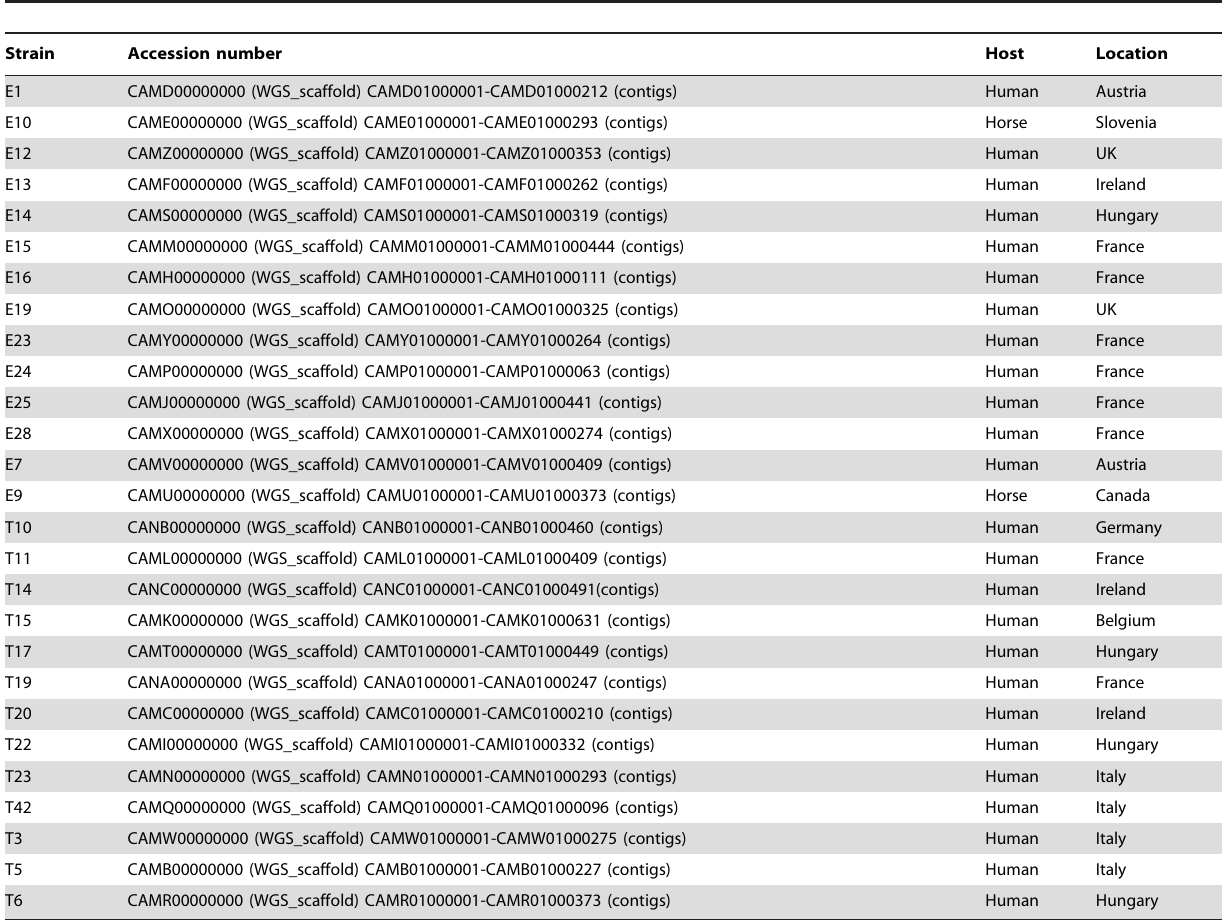
Table 1. Listing of accesion number, host and location of isolation of the 27 C. difficile strains sequenced for this study.